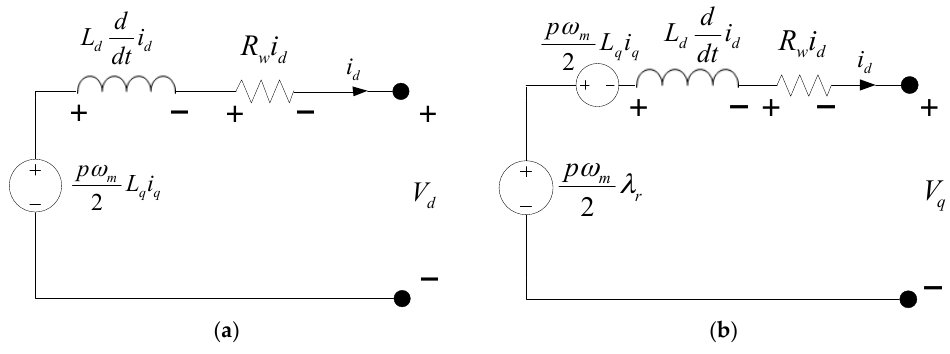
Figure 7. AFPMA equivalent circuit: ( a ) d -axis model; ( b ) q -axis model.